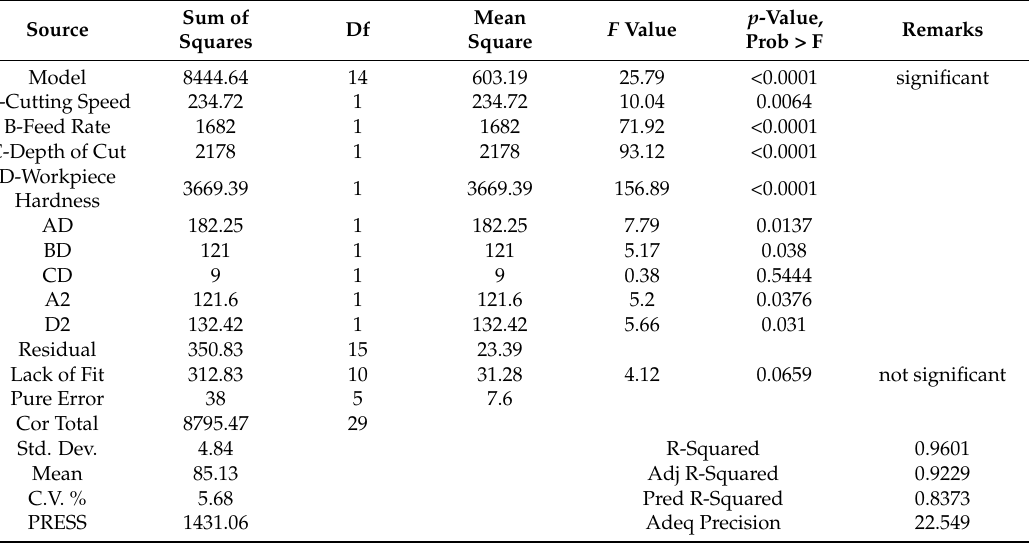
Table 10. Model of Tangential Force for CBN-III